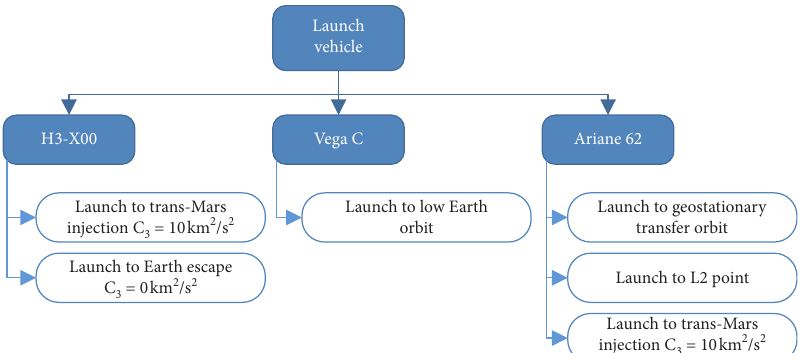
Figure 2: An overview of the launch vehicle options and corresponding injection orbits considered for study.